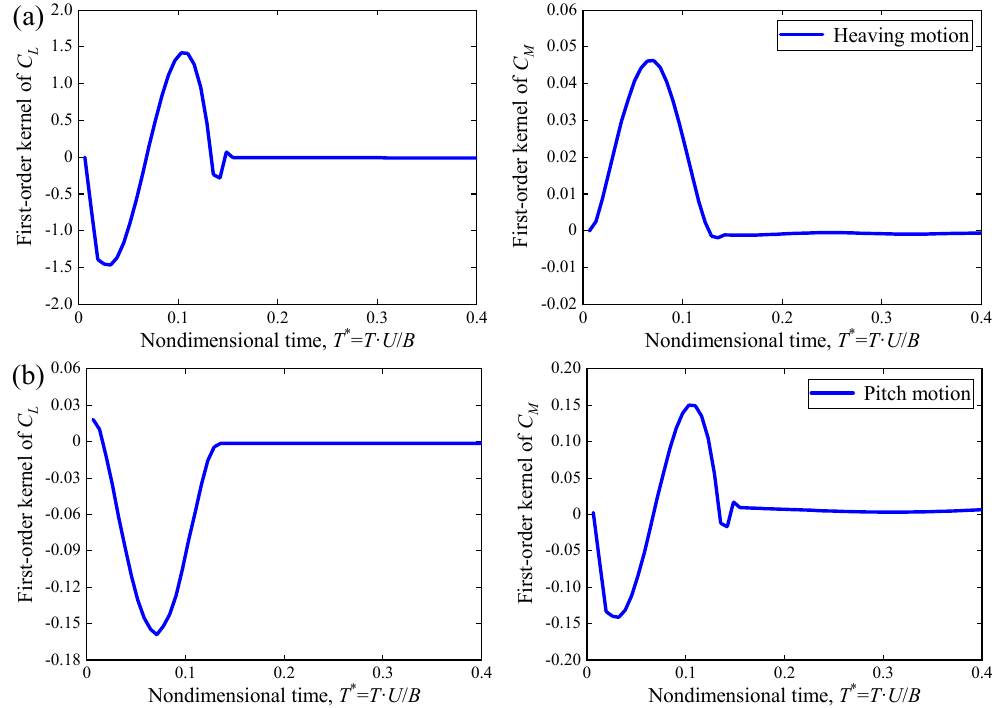
Figure 7. The first-order kernels of lift and moment coefficients ( a ) in the heaving motion; ( b ) in the pitch motion.